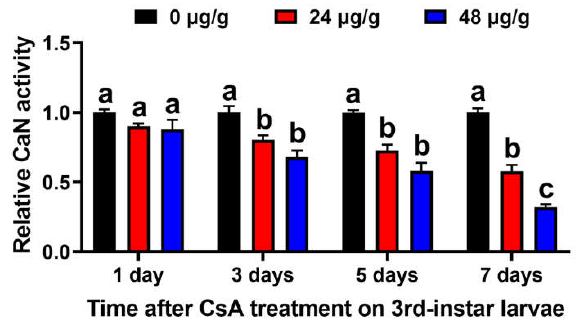
Figure 3. CaN activity of the larval midgut after treatment with CsA for 1, 3, 5, and 7 days. Data are means ± SE of three biological replicates. Different lowercase letters upon error bars indicate signif- icant differences analyzed using ANOVA followed by Tukey’s (equal variances assumed) or Dun- nett’s T3 (equal variances not assumed) HSD test on SPSS Statistics 20 at level of p <